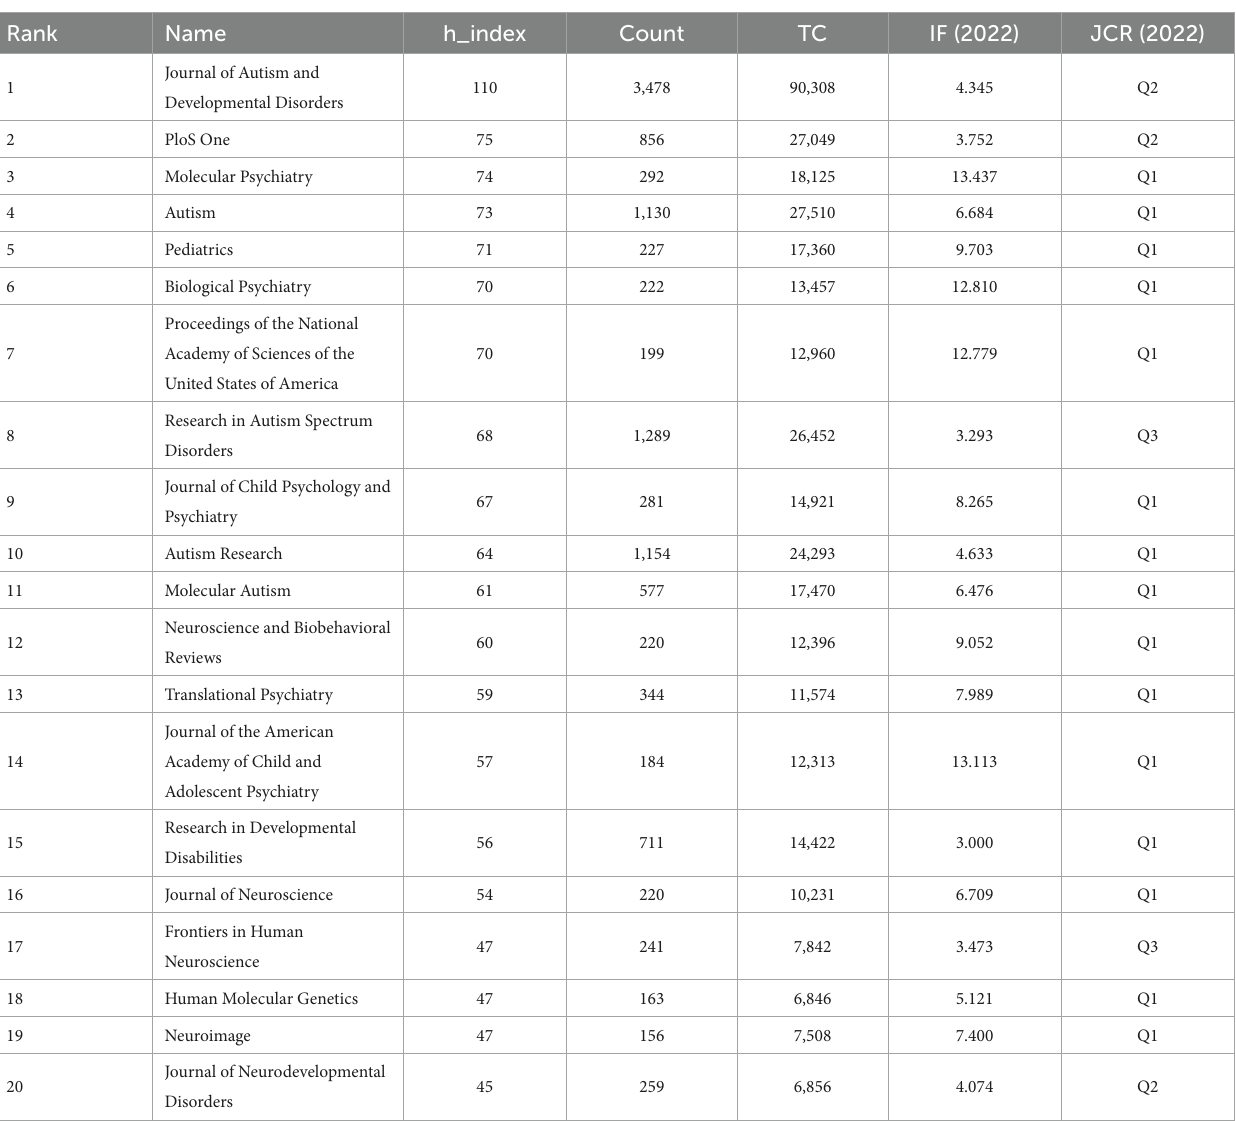
TABLE 3 Top 20 journals ranked by